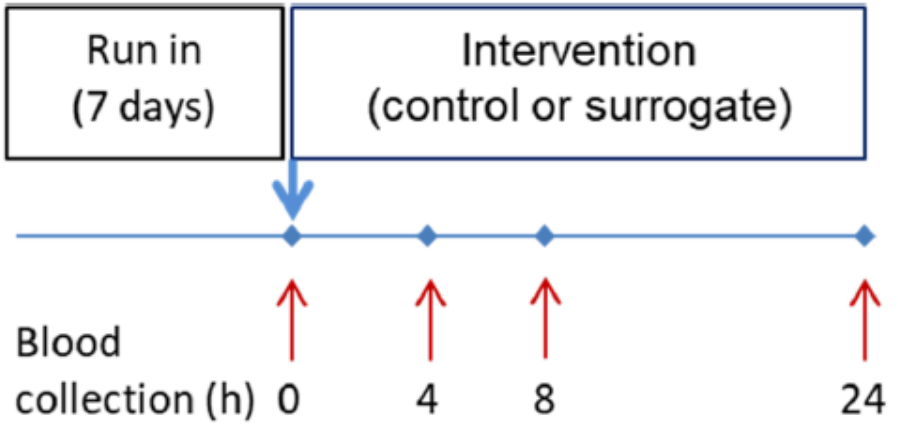
Figure 1. Schematic of the intervention study. After a run-in period without sweetener intake (7 d), study participants consumed a recombination of sweeteners (surrogate) or mineral water (control). Intervention period was 24 h.